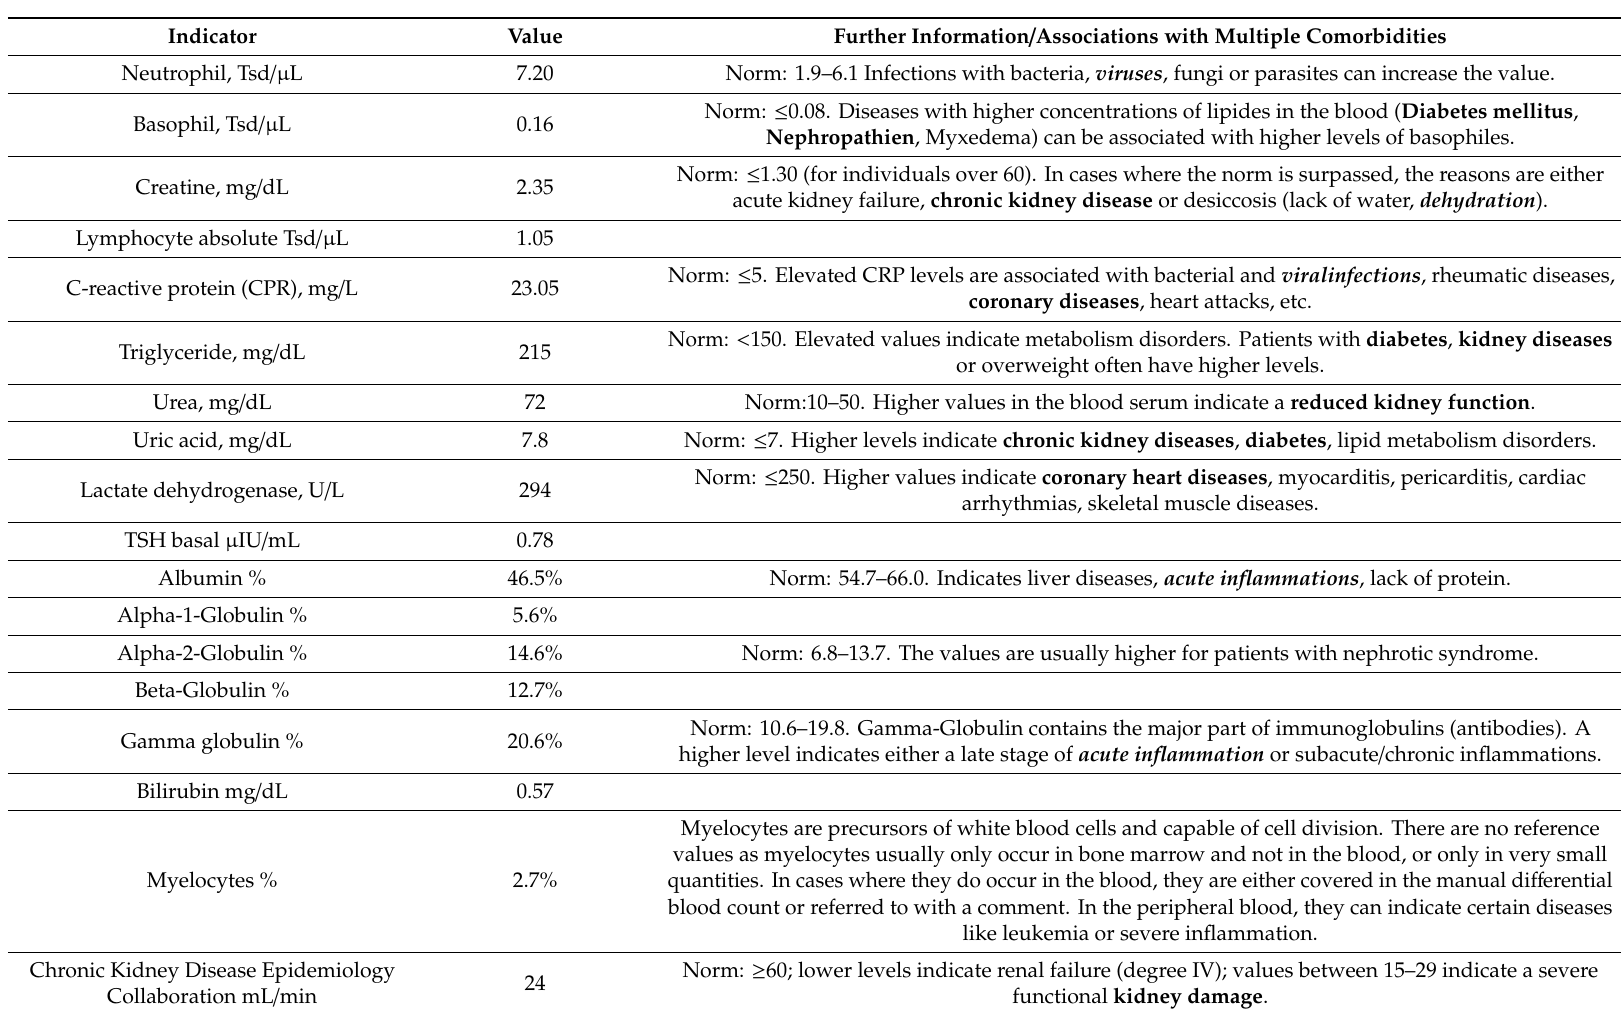
Table 3. Laboratory